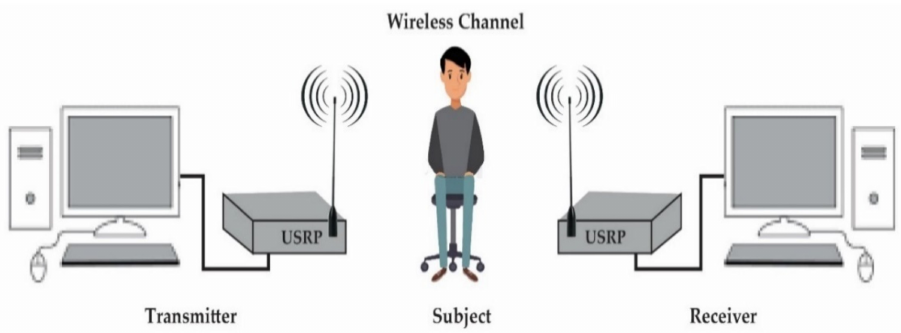
Figure 2. System